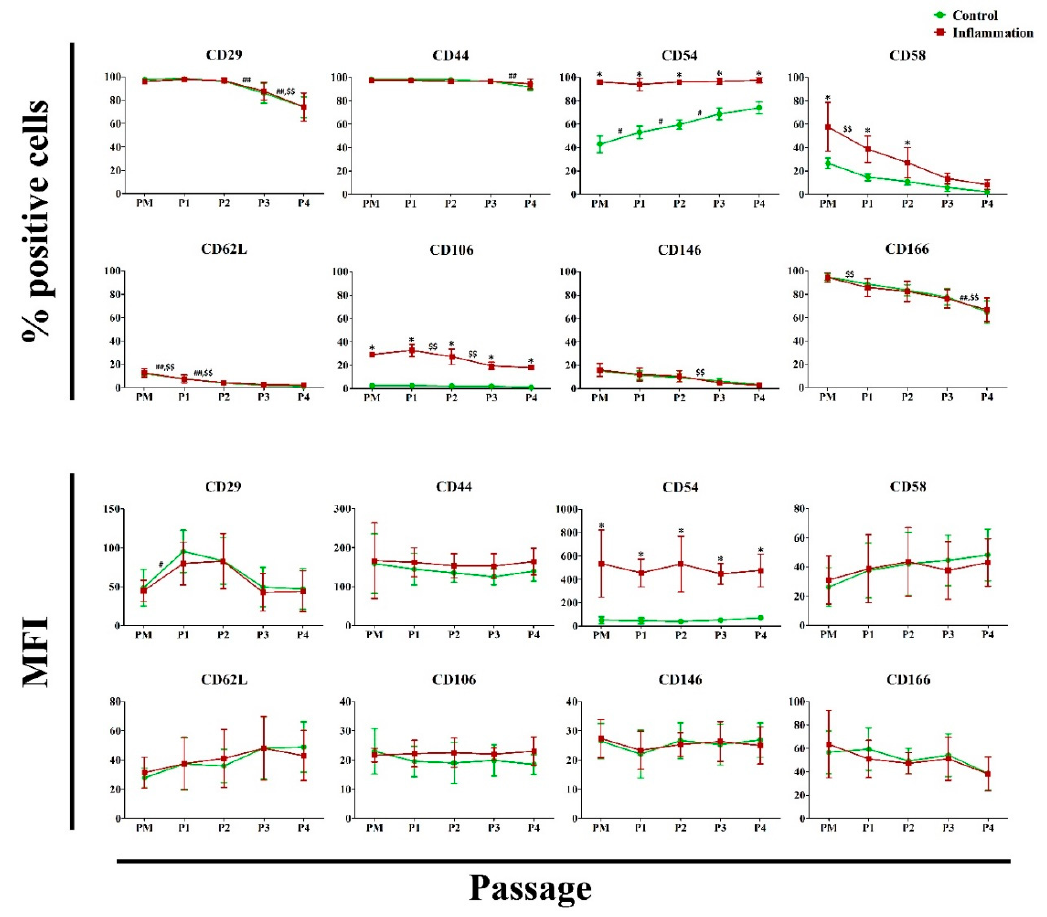
Figure 4. Impact of inflammation and cell passaging on the expression of cell adhesion molecules in AT-MSCs. Flow cytometric analysis was used to determine the percentage of positive cells and the protein expression per cell (MFI). The values are expressed as mean ± SD and originate from six different AT-MSC donors. * Significantly higher percentage or amount per cell in inflammation-stimulated AT-MSCs compared to regular AT-MSCs ( p -value < 0.05). # Significantly higher percentage or amount per cell in regular AT-MSCs compared to the consecutive passage ( p -value < 0.05). ## Significantly lower percentage or amount per cell in regular AT-MSCs compared to the consecutive passage ( p -value < 0.05). $$ Significantly lower percentage or amount per cell in inflammation-stimulated AT-MSCs compared to the consecutive passage ( p -value <